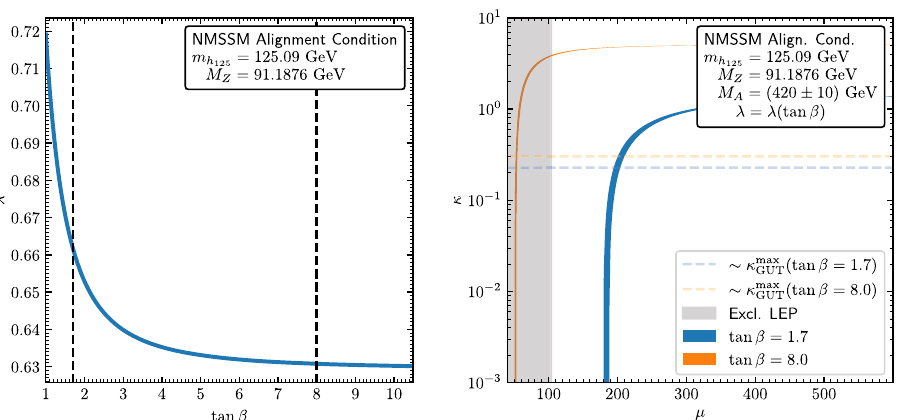
Fig. 11 Left: λ as a function of tan β obtained from the first alignment condition given in Eq. (10). The black dashed lines indicate the values tan β = 1 . 7andtan β = 8 . 0 usedinourbenchmark scenarios(seetext). Right: κ as a function of μ obtained from the second alignment condi- tion given in Eq. (11) for tan β = 1 . 7 (blue) and tan β = 8 . 0 (orange),